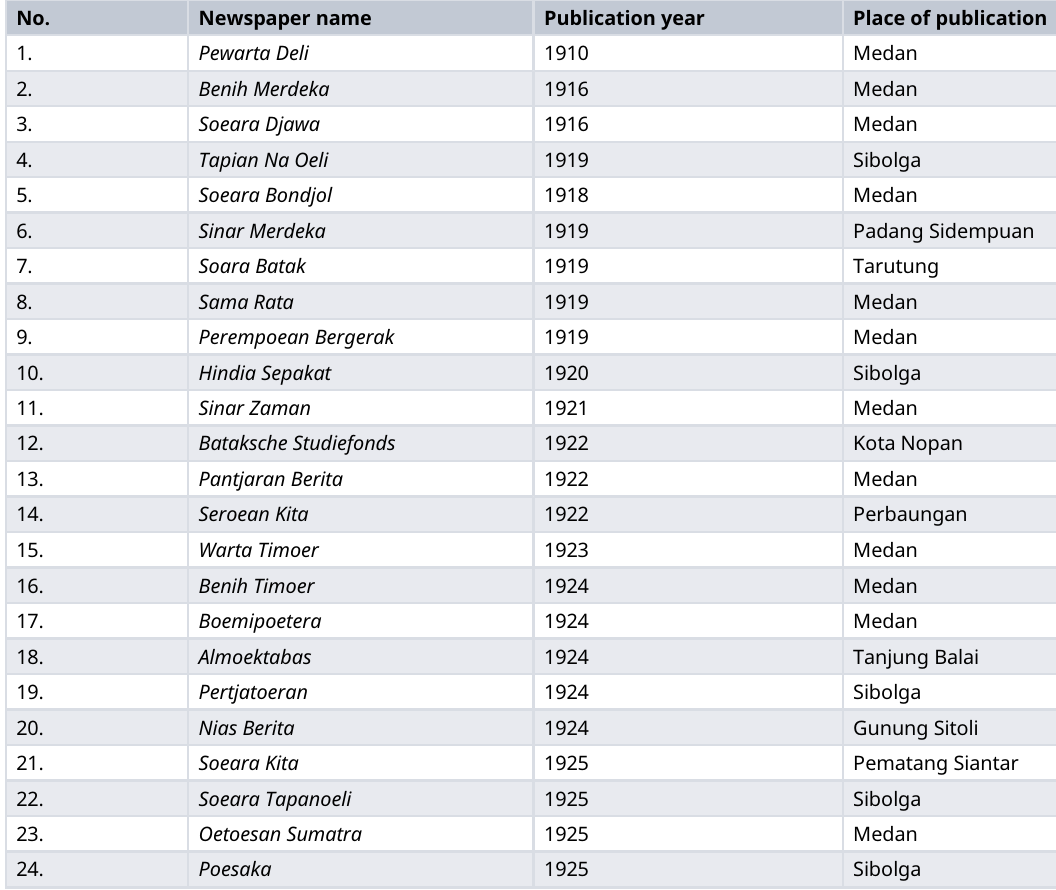
Table 1. The indigenous newspapers published in North Sumatra (1910-1925). 6